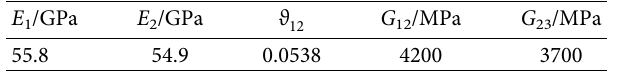
Table 1: Properties of